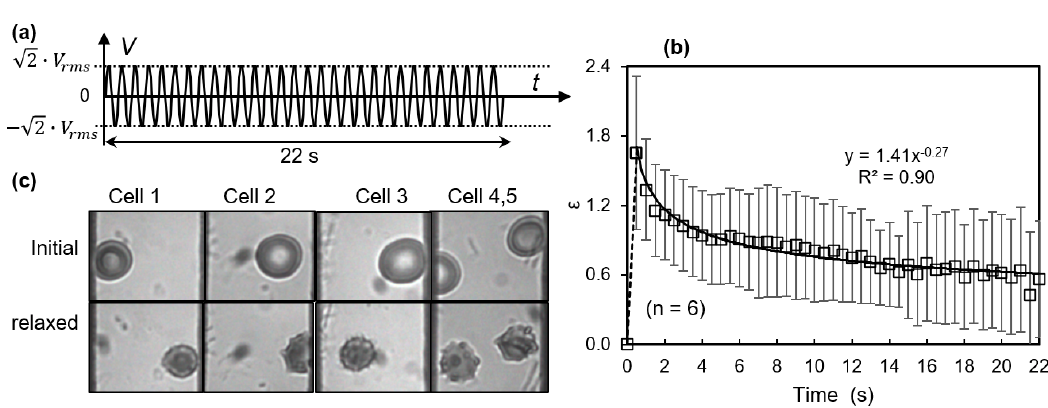
Figure 6. Erythrocyte response to high field strength excitations. ( a ) Induced membrane failure test was conducted by subjecting erythrocyte suspension to a constant high electric field strength for a duration of 22 s and removed after that. V rms value is 7 V. ( b ) Such a load caused a strain in erythrocyte membranes as a function of time. It decreased gradually in an exponential function ( n = 6). Error bar represents the standard deviation. ( c ) After the loading condition was removed, cells recovered with permanent damages in the membranes, similar to the echinocytes with small volume and thorny projections at multiple places.